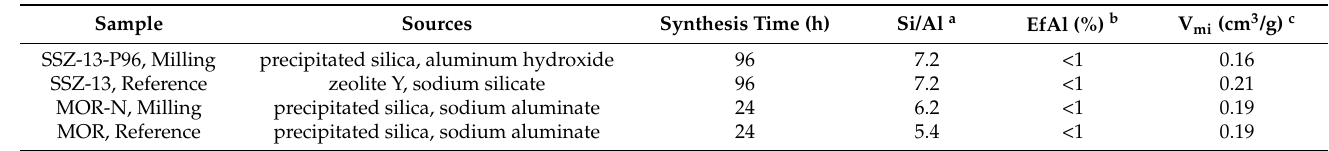
Table 5. Characteristics of selected examples of solvent-free zeolites prepared with milling pretreatment vs. reference zeolites prepared by classical hydrothermal